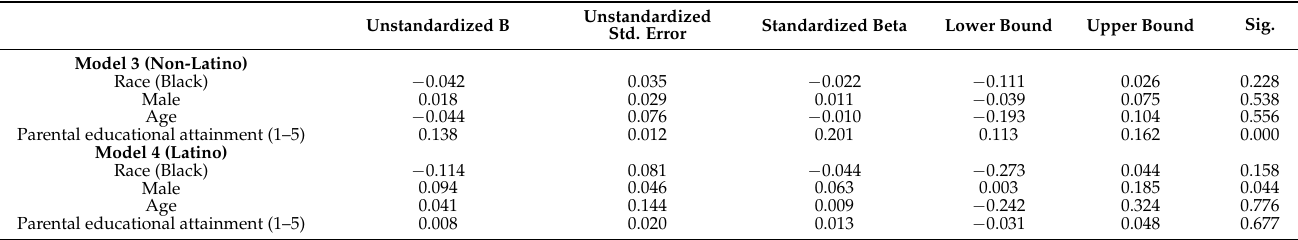
Table 3. Stratified models in non-Latino and Latino youth.